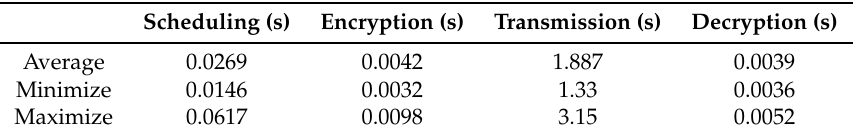
Table 6. Execution time of the